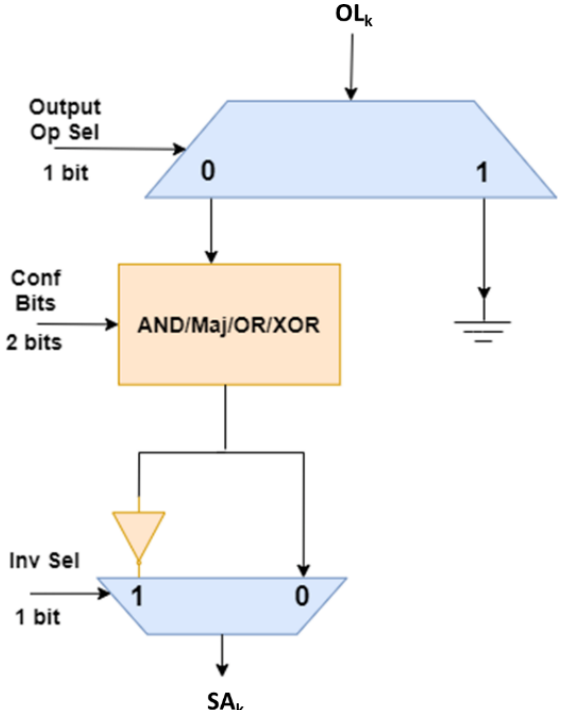
Figure 7. Compact block-level description of the configurable voltage-based sensing module, which connects to a crossbar output line OL k (BE of memristors), enabling either memory or logic operations. The block entitled “AND/MAJ/OR/XOR” corresponds to the SA circuit in Figure 4.